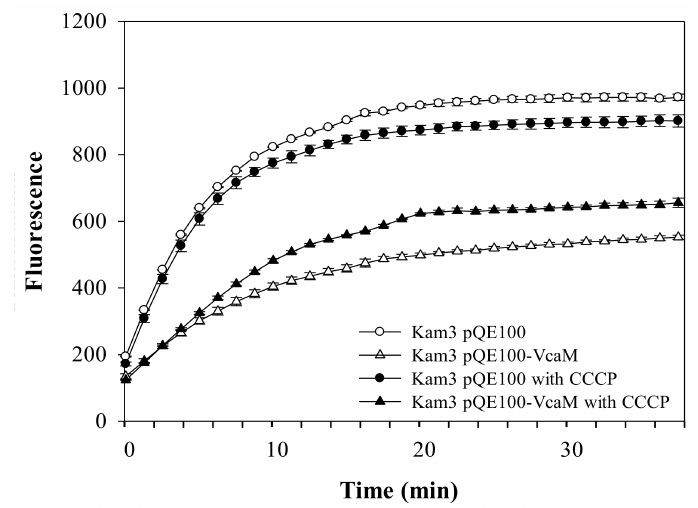
Figure 5. Drug accumulation of H33342 in E. coli Kam3 overexpressing VcaM in the presence of membrane decoupling secondary transporter inhibitor CCCP. H33342 was incubated for 38 min in the presence of 20 µ g/mL